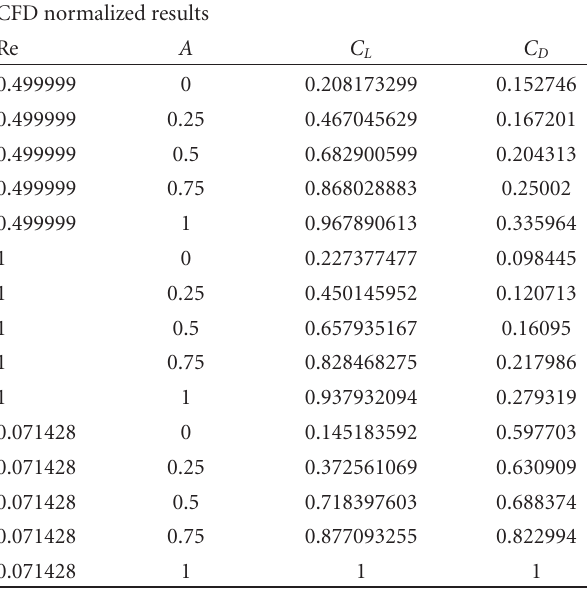
Figure 13: Optimum C L versus α for all airfoils. Table 1: Normalized design variables and objective function values from CFD simulations of NACA 63-421.